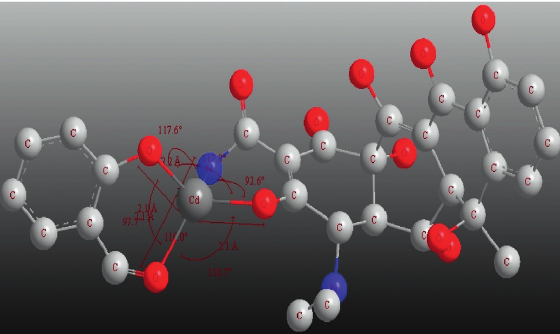
Figure 6: Optimized geometry of the Cd-OTC/Sal complex.